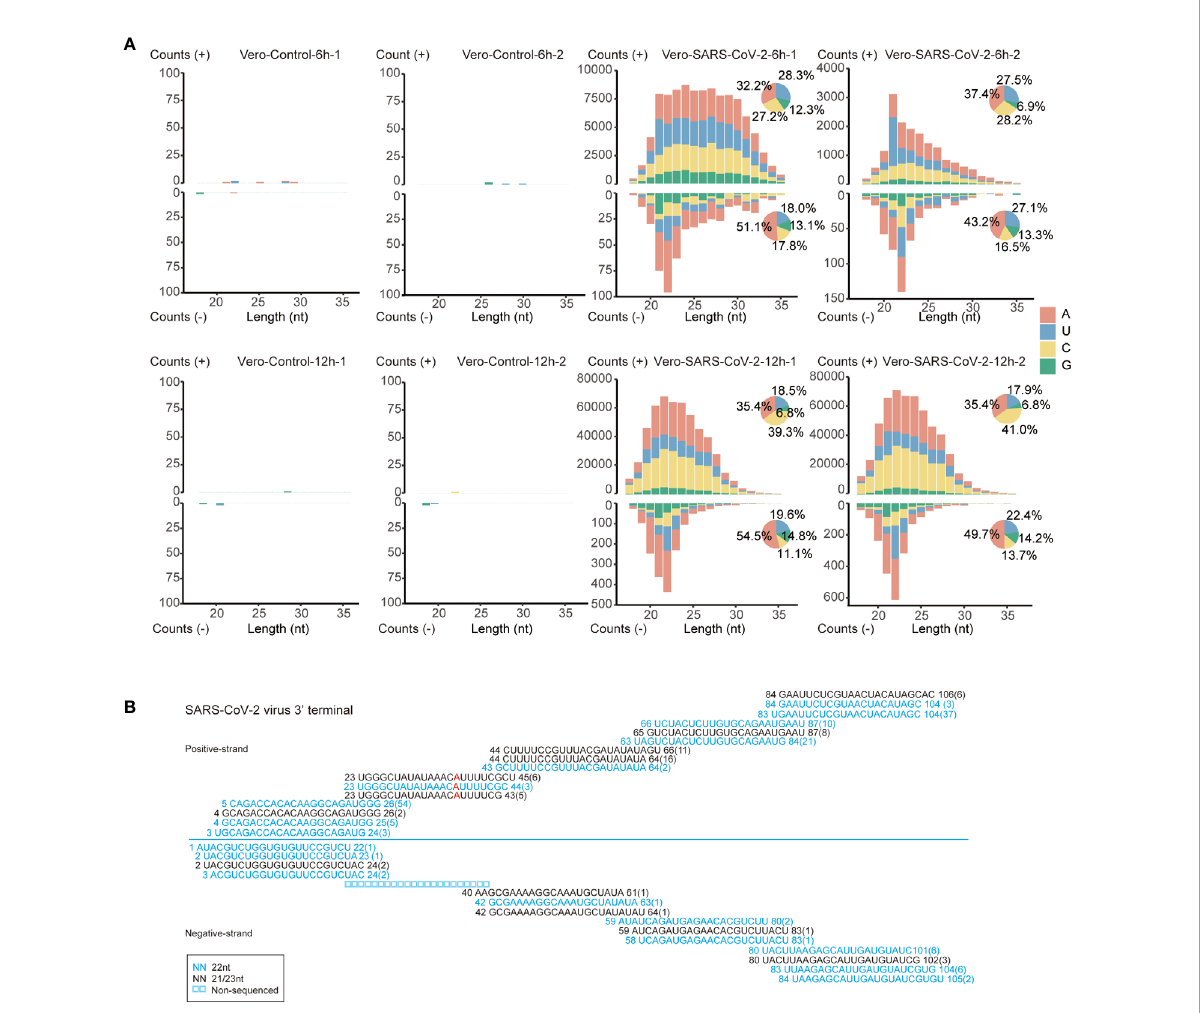
FIGURE 4 The inducement of RNAi in SARS-CoV-2 infected Vero cells. (A) Size distribution and abundance of SARS-CoV-2 vsRNAs sense and antisense reads from Vero cells at 6 and 12 hpi. Pie plots represent vsRNAs initiated with A/U/C/G in positive and negative strands. (B) Read sequences along the 3 ’ -terminal sequence of SARS-CoV-2 viral genome. Read counts (in brackets), read length, non-sequenced reads and genomic position are indicated and mismatched bases are mentioned in